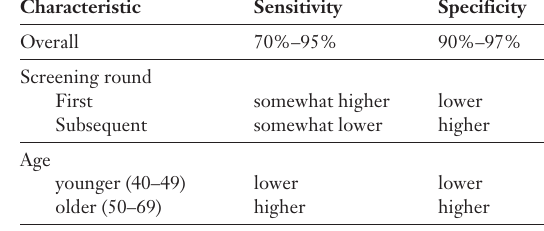
Estimated outcomes among 10 000 women starting at age 50–55 to undergo mammography screening every two years for 10